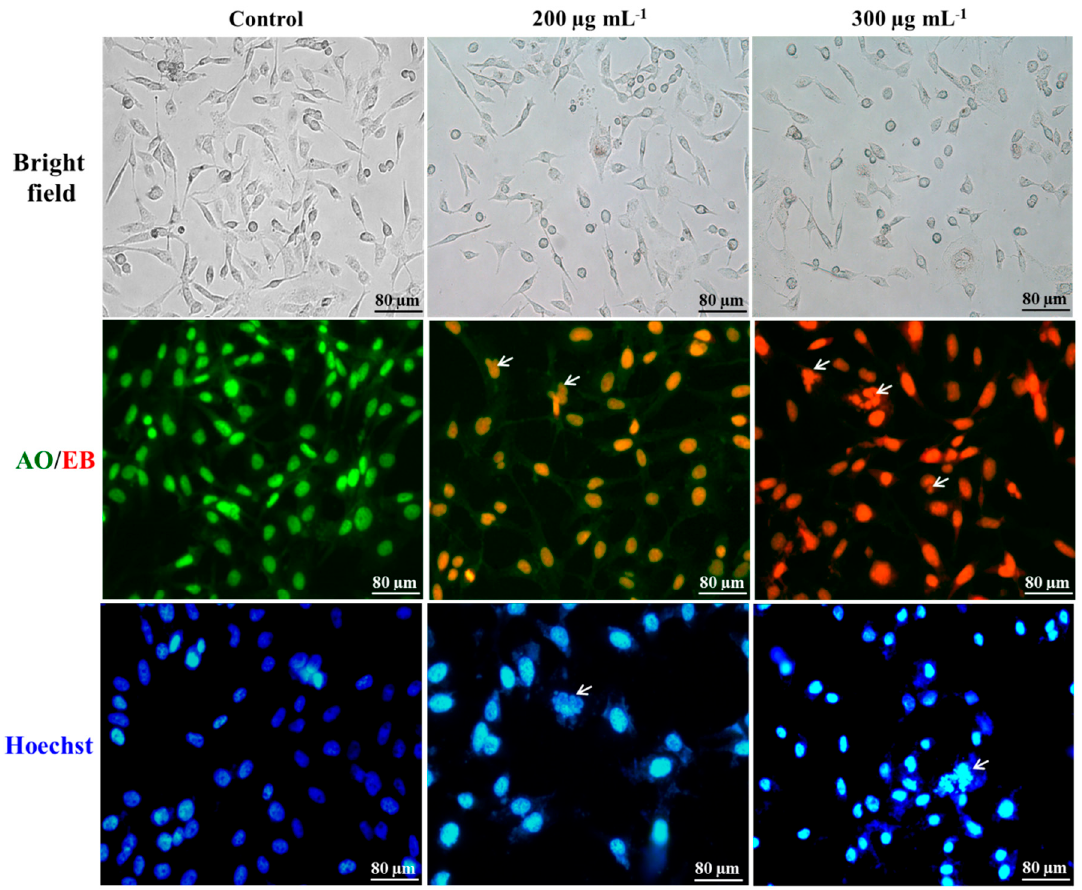
Figure 5. Bright field and fluorescent microscopic images of PDT-treated MBA-MD-231 cells with or without phycocyanin using 625-nm laser irradiation for 30 min at a power density of 80 mW·cm − 2 .